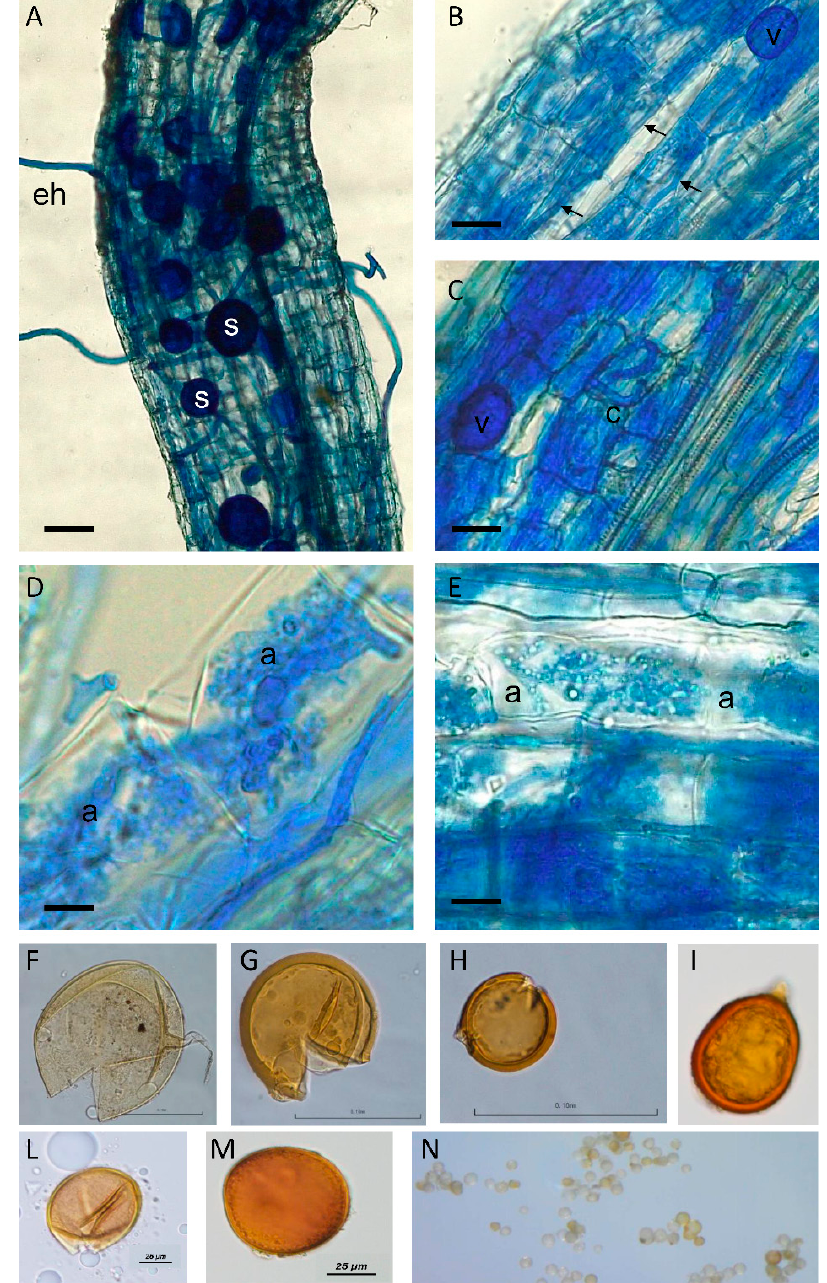
Figure 2. Arbuscular Mycorrhizal Fungal (AMF) colonized Lycium ruthenicum roots after staining with cotton blue to highlight several fungal structures. ( A ) External hyphae (eh) and spores (s) are evident around the root. Bar = 200 μ m. ( B ) At a higher magnification, intercellular hyphae are evident (arrows). A vesicle (v, a storage structure) is also evident. Bar = 150 μ m. ( C ) A coil (c) is present inside a cortical cell, as well as a vesicle (v). Bar = 115 μ m. ( D , E ) Magnification of cortical cells containing arbuscules (a), which are considered the key symbiosis structures where nutritional exchanges occur. Bars = 50 and 30 μ m, respectively. ( F – N ) Spores of different AMF morphotypes, mirrored by the different spore morphology, isolated from the soil of trap plants.